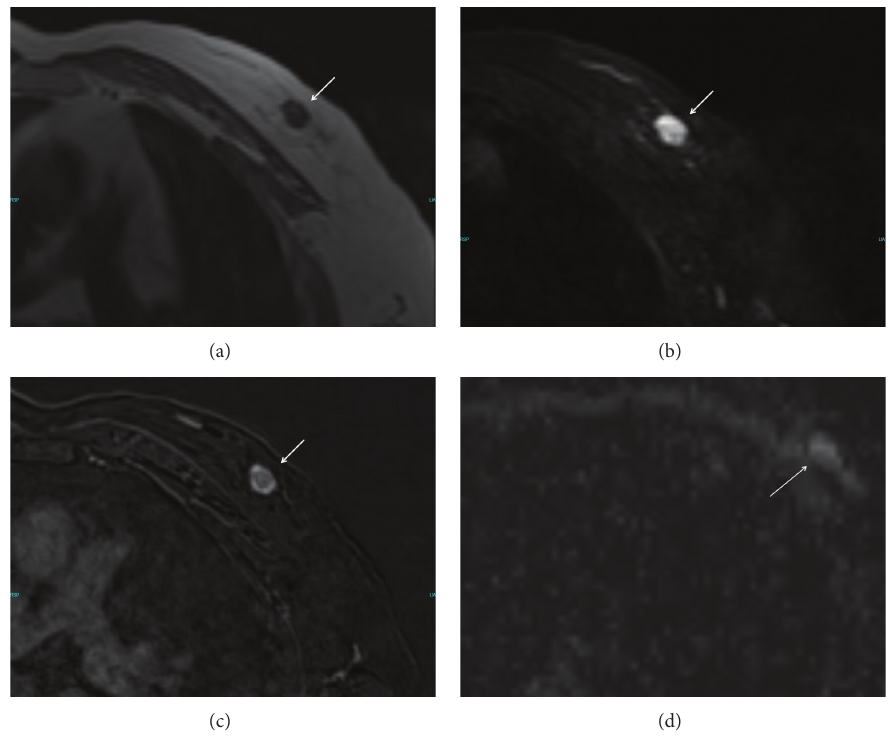
Figure 2: Magnetic resonance imaging findings of the breast mass. (a) T1-weighted spin echo MR image shows a focal mass with low signal intensity and smooth borders. (b) The fat-suppressed fast spin echo T2-weighted MR image shows a focal mass with high signal intensity. (c) Gd-enhanced fat-suppressed T1-weighted MR image shows strong heterogeneous enhancement of the mass and linear areas of low signal intensity in keeping with internal septations. (d) ADC value of the